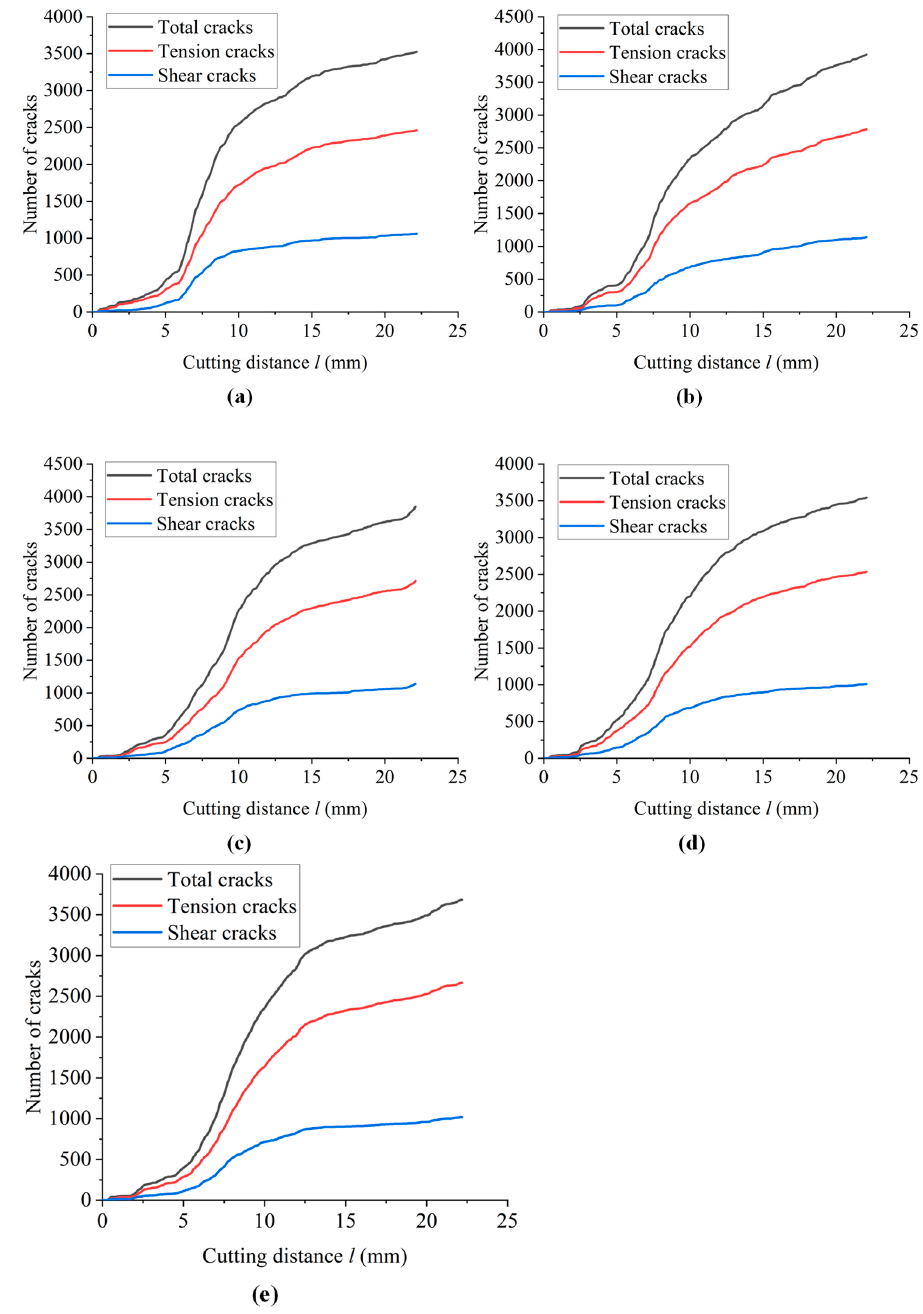
Figure 9. Variation characteristics of crack number of samples with different bedding dips: ( a ) 0°; ( b ) 30°; ( c ) 45°; ( d ) 60°; ( e ) 90°.